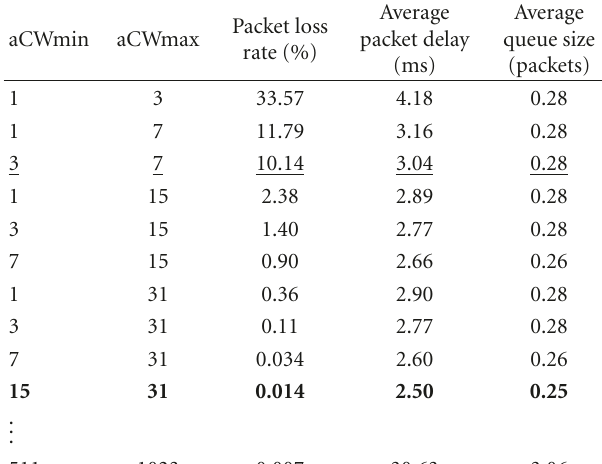
Table 5: E ff ects of varying aCWmin, aCWmax on the RT tra ffi c, for 20 RT stations—MSP = 10ms.